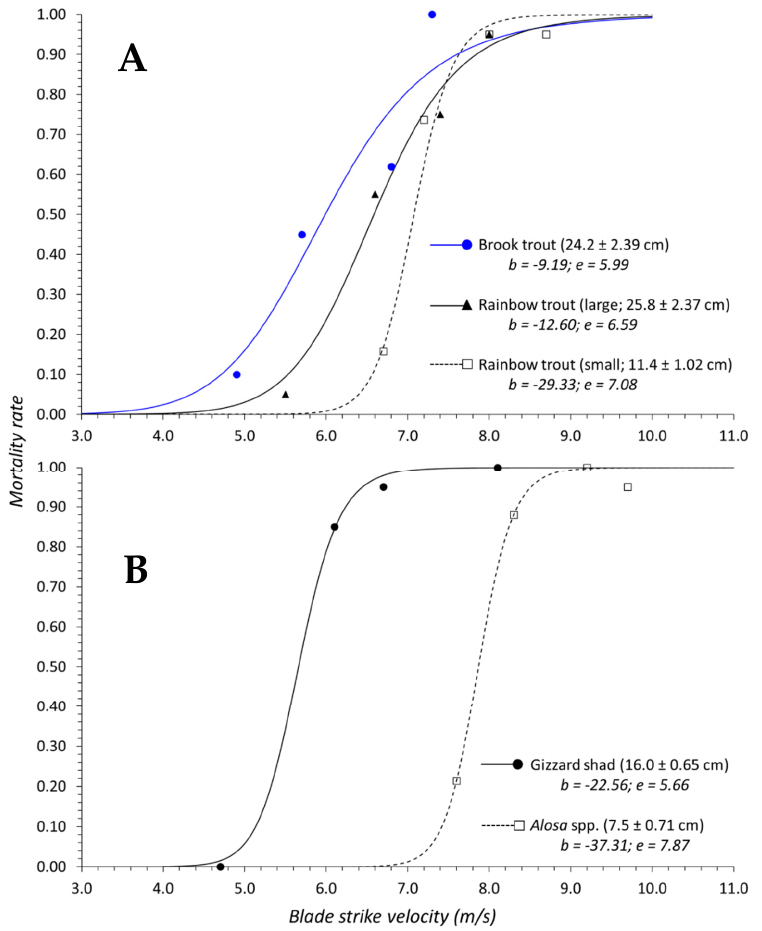
Figure 3. Graphs of dose–response curves using log-logistic regression to predict mortality according to blade strike velocity (m/s). Curves were produced for ( A ) small (black; dashed line; open squares) and large rainbow trout (black; solid line; closed triangles) and brook trout (blue; solid line; closed circles) or ( B ) gizzard shad (black; solid line; closed circles) and Alosa spp. (black; dashed line; open squares). Table 1. Results of log-logistic regression of mortality against blade strike impact velocity for each species, size class within a species, or combination of species.